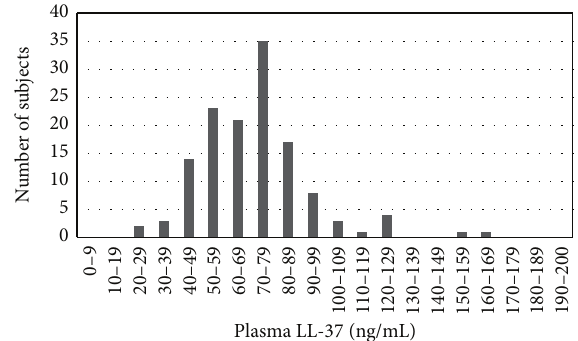
Figure1:HistogramoffrequencydistributionofplasmaLL-37level.